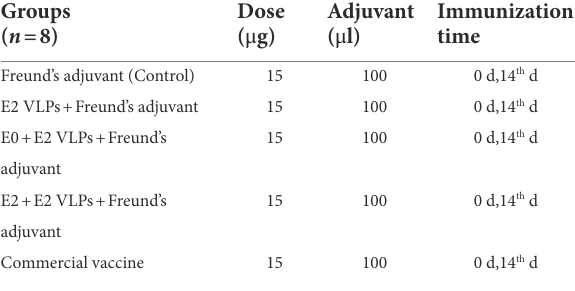
TABLE 1 Information on immunization